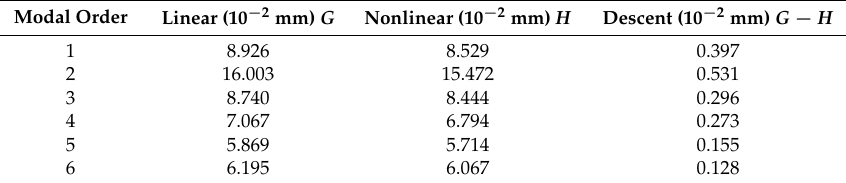
Table 6. The first 6 order linear and nonlinear resonant responses of the hard-coating cylindrical shell under a 5 g excitation level.